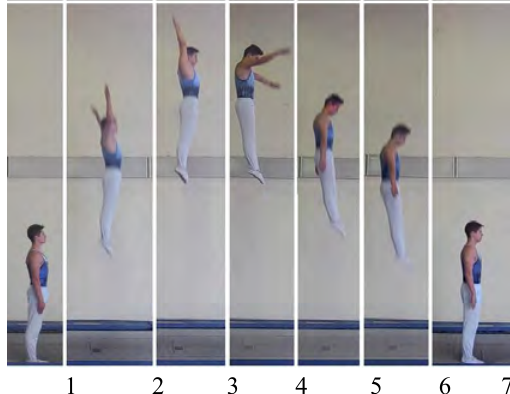
Fig.3. Temp jumps Recommendations: keep vertical position (shots 1 – 3, half-closed working carriage) – head a little bent